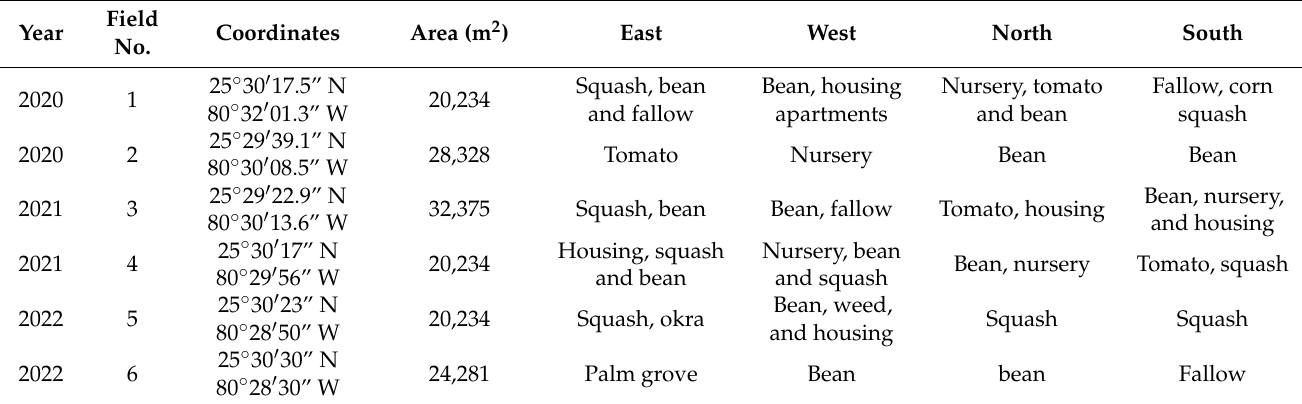
Table 1. Profiles of six snap bean fields used for assessing within-field distribution of